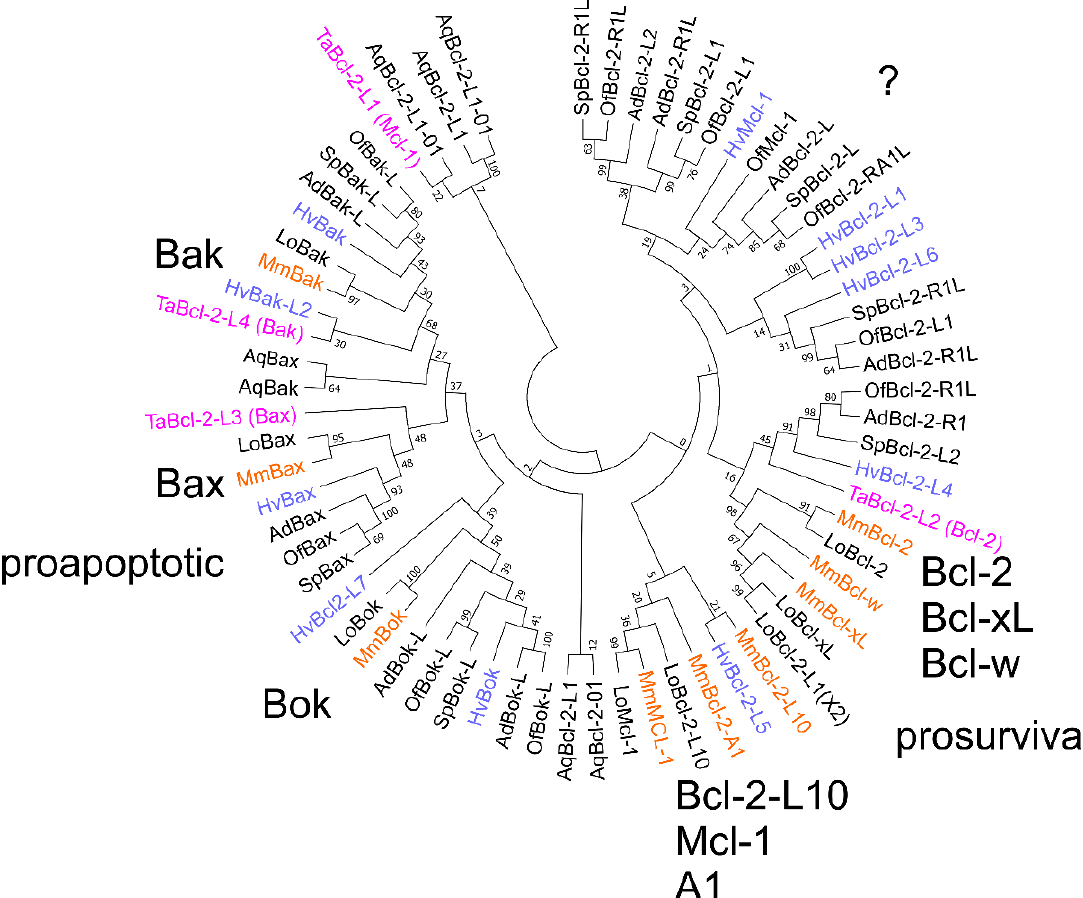
Figure 3. Phylogenetic analysis of Bcl-2 proteins from basal metazoans, garfish and mouse. Evolutionary analyses were conducted in MEGA7 [35] and molecular phylogenetic analysis was performed using the maximum likelihood method as described in the methods section. The analysis involved 66 protein sequences. All positions containing gaps and missing data were eliminated. There were a total of 114 positions in the final dataset and the percentage of trees in which the associated taxa clustered together is shown next to the branches. The mouse Bcl-2 family members are indicated in large letters along with their apoptotic activity. Species abbreviations: Aq, A. queenslandica ; Mm, M. musculus ; Hv, H. vulgaris ;